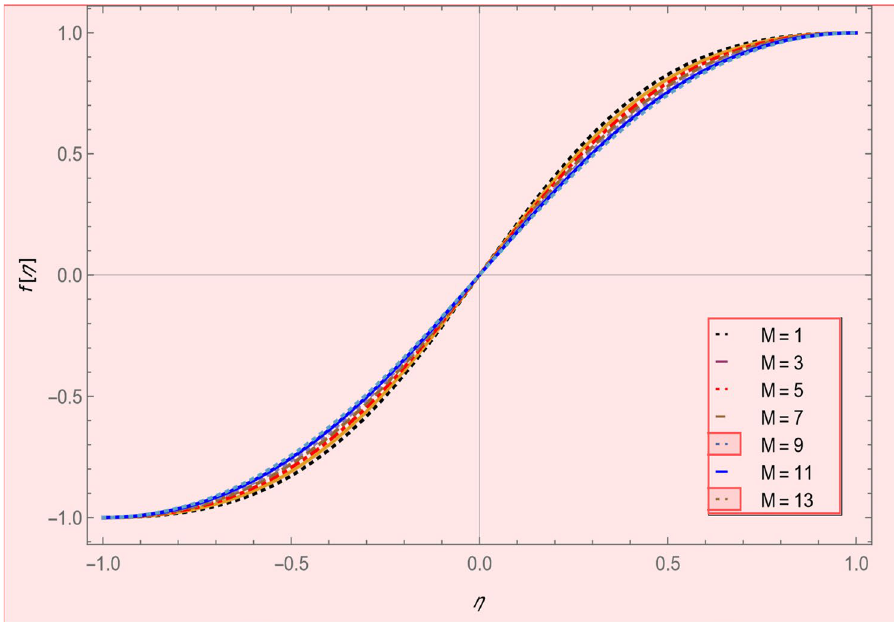
Figure 8. Axial velocity profile effect in magnetic parameter for α = 4, R = − 1, ϕ 1 = ϕ 2 = 0.04, SC = 1, Pr = 6.2.